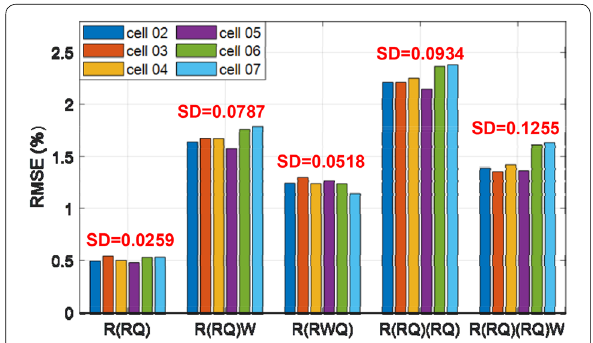
Figure 12 RMSE and standard deviation for the estimation results of different